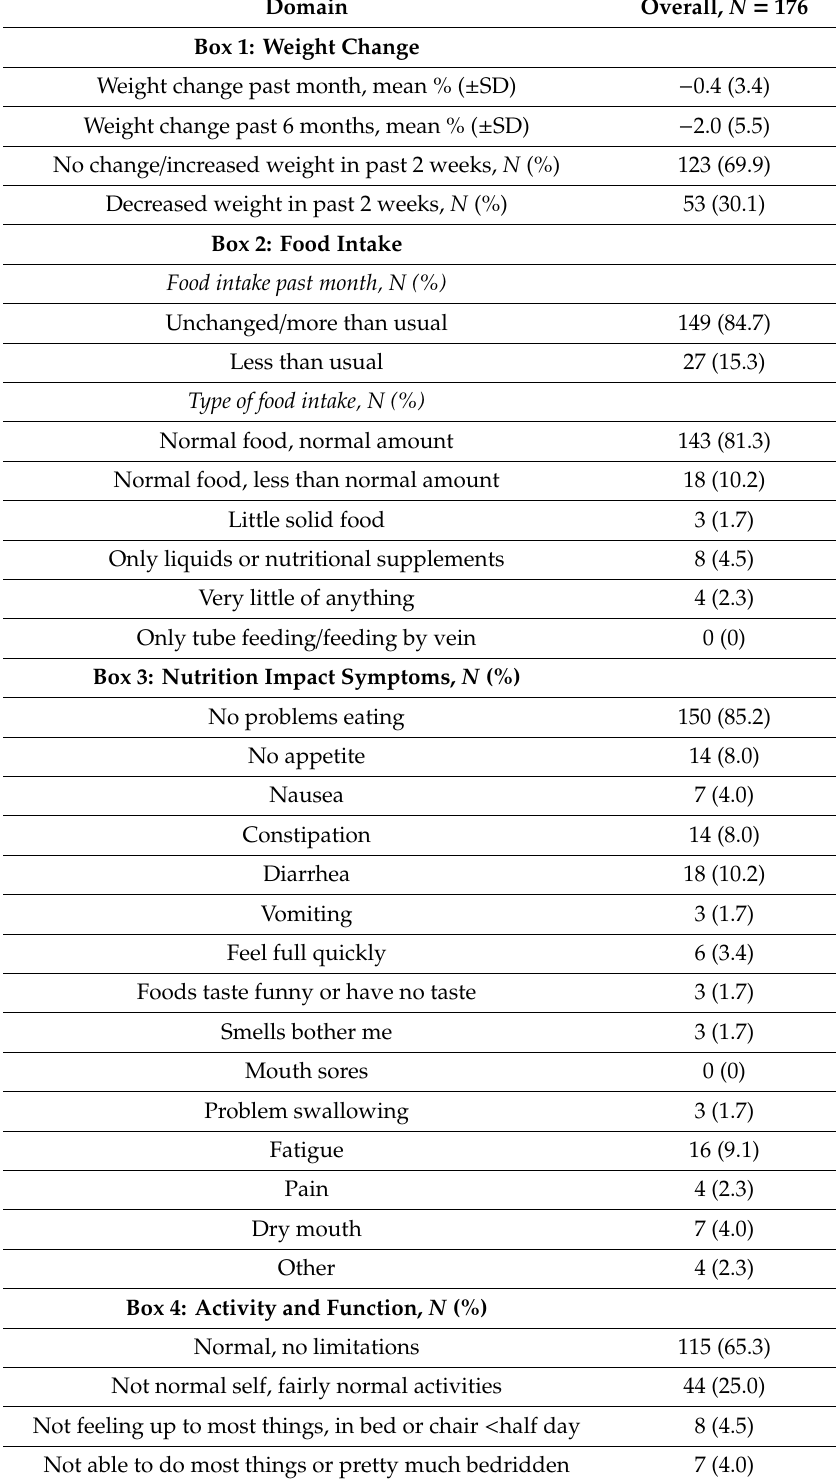
Table 2. Nutritional risk factors by PG-SGA SF